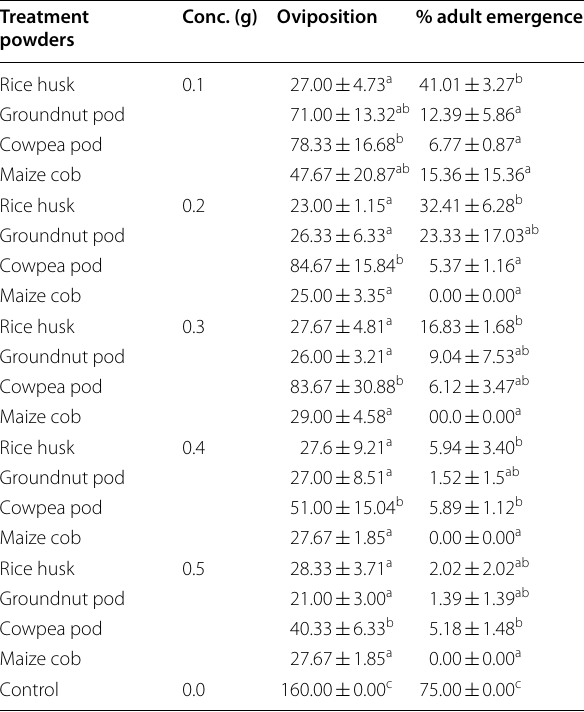
Mean followed by the same letters within the same column are not significantly different ( p > 0.05)